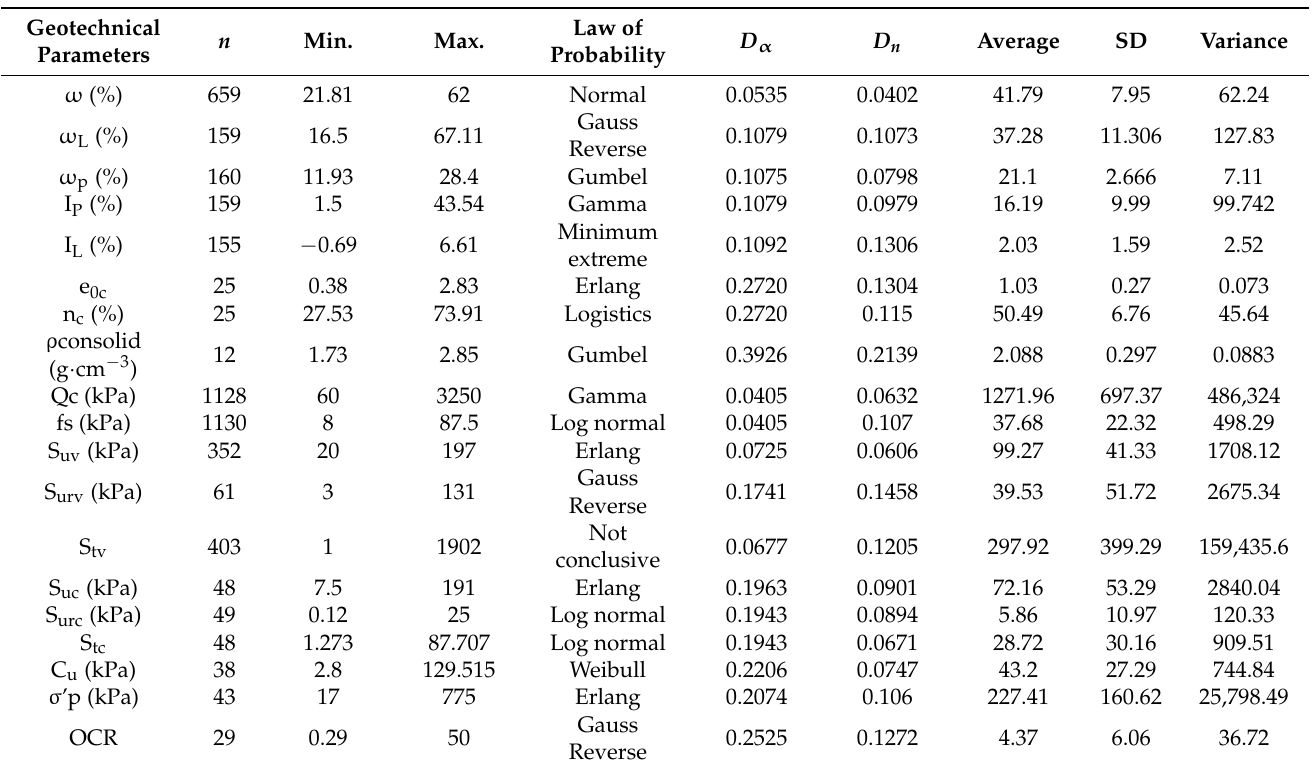
Table 3. Uncertainties of physical and mechanical